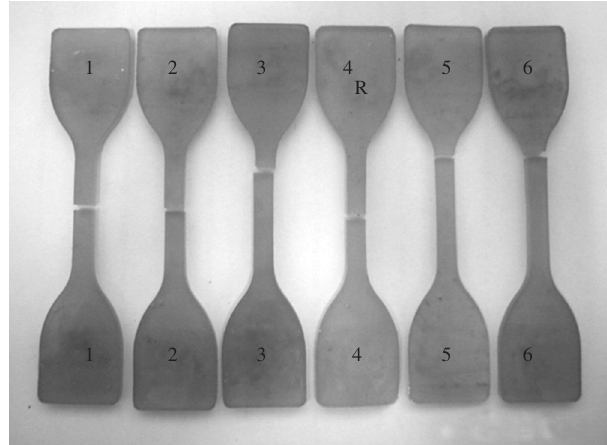
Figure 3. Samples used to determine the resin’s elasticity modulus.